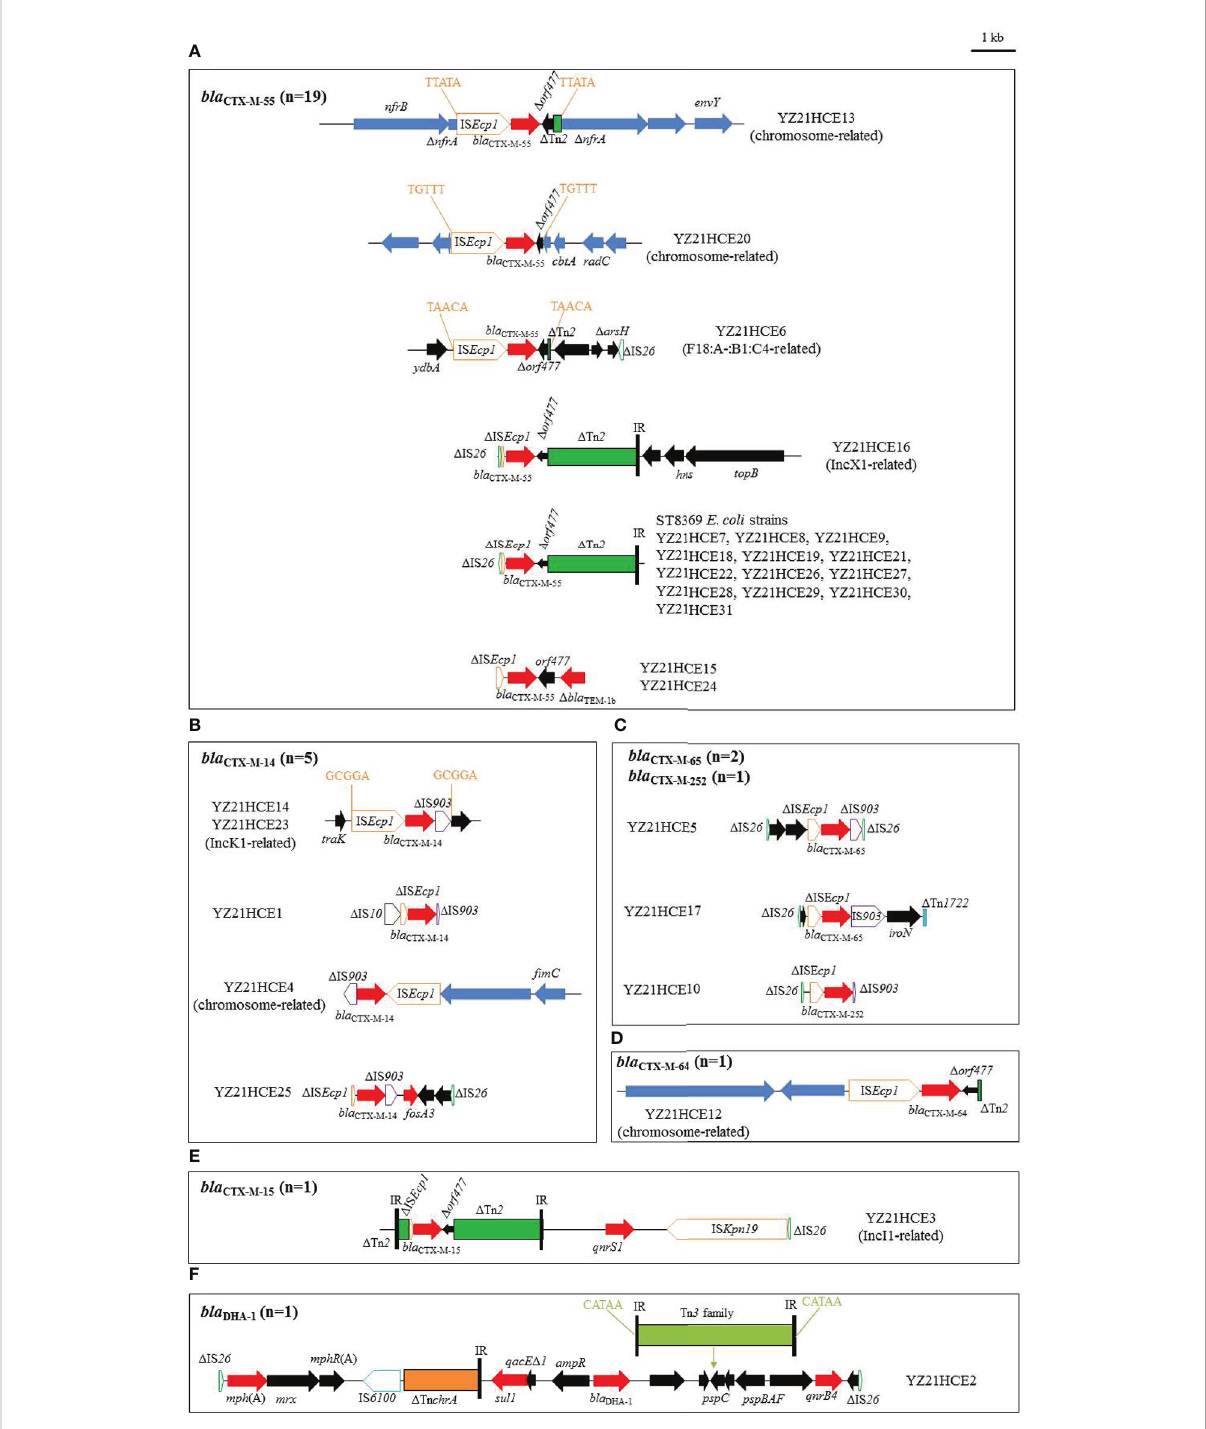
FIGURE 2 The genetic environments of blaCTX-M/blaDHA in 30 E. coli isolates in this study. (A) blaCTX-M-55; (B) blaCTX-M-14; (C) blaCTX-M-65/-252; (D) blaCTX-M-64; (E) blaCTX-M-15; (F) blaDHA. The extents and directions of antibiotic resistance (red arrows) and other genes (black arrows) are indicated. The blue arrows indicate chromosomal genes. ISs are shown as boxes labeled with their name. Tall bars represent the inverted repeats (IR) of transposon. D indicates a truncated gene or mobile element. Arrows and sequences indicate direct